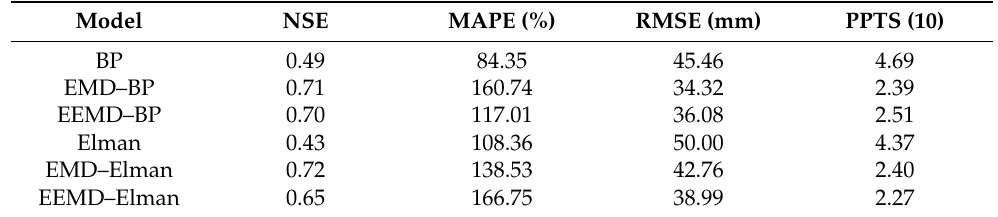
Figure 9. Forecasted and observed monthly streamflow during validation period by all four double- coupled models. Table 3. Evaluation of double-coupled models' monthly runoff predictions during the validation period.